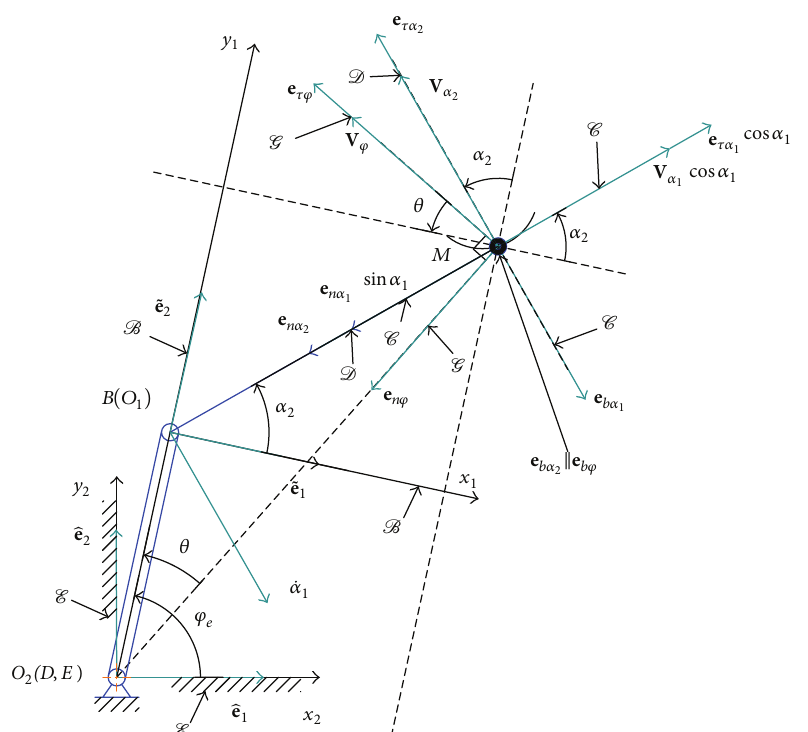
Figure 13: Swaying scheme for velocity kinematics analysis in spherical coordinates of load 𝑀 at the cable 𝑀𝐵 , which is fixedly attached in the point 𝐵 to the crane boom 𝐵𝑂 2 , in the horizontal plane ( 𝑥 1 𝑦 1 ) for nonlinear model derivation in relative spherical coordinates.